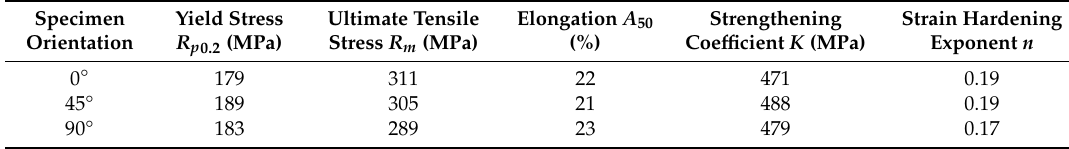
Table 2. Selected mechanical properties of DC04 steel sheet.